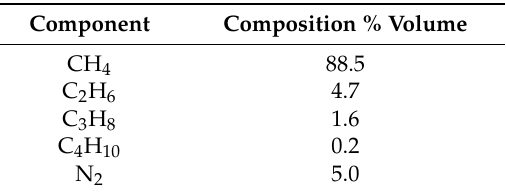
Table 2. Natural gas